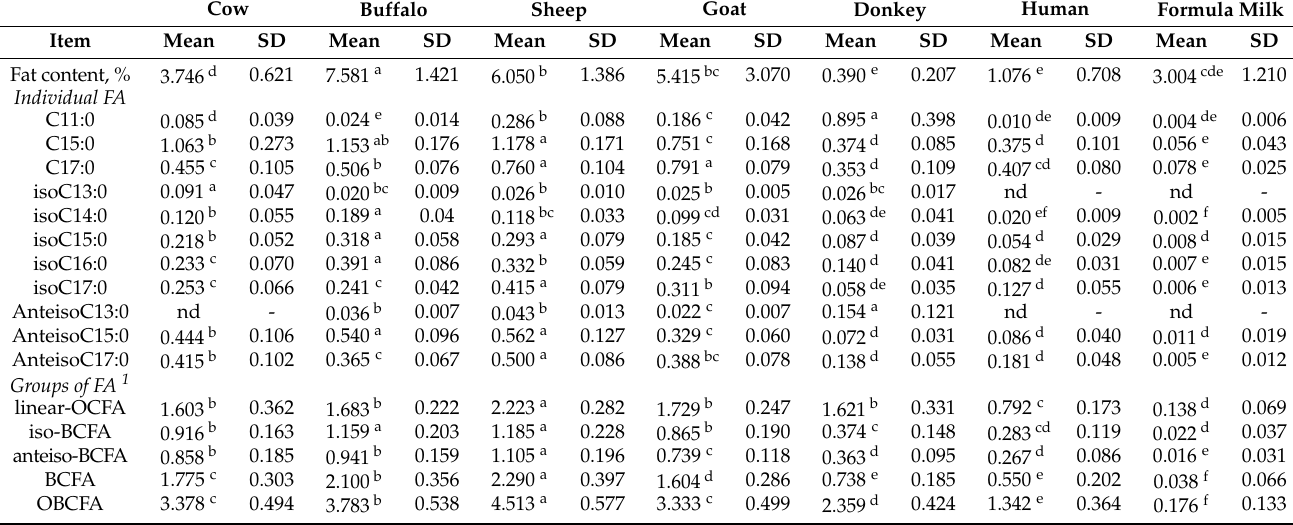
Table 1. Individual and groups of odd- and branched-chain fatty acids (g/100 g of FAME) of formula milk and milk from buffalo, cow, donkey, goat, sheep, and human. Buffalo Sheep Goat Donkey Human Formula